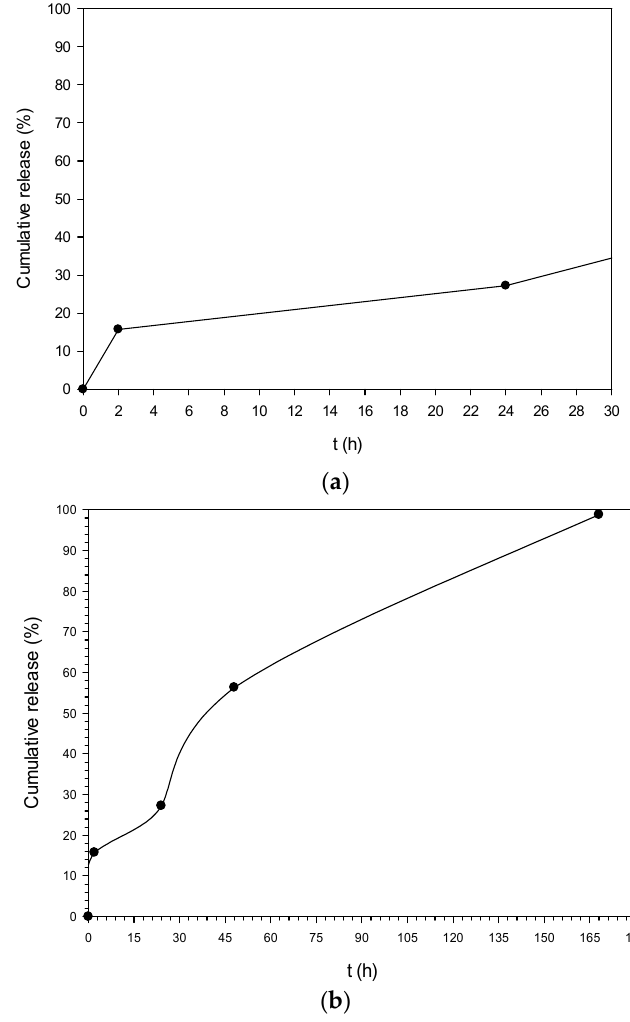
Figure 7. In vitro release profile of PLA nanoparticles loaded with oil leaves extract (OLE-loaded NPs) (pH 5.6, T = 37 °C). ( a ) 0–24 h; ( b ) 0–168 h.